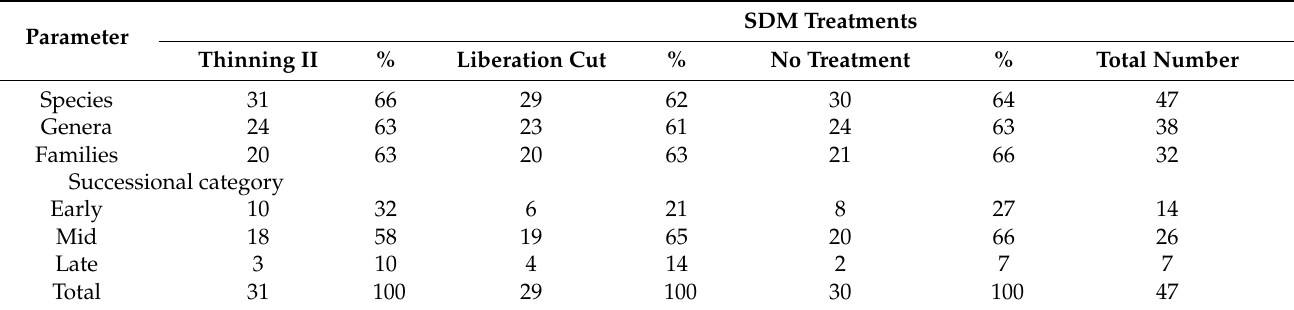
Table 1. Accumulated number and percentage of families, genera, and species recorded in different silvicultural treat- ments in the Ocotones forest, Chiapas, Mexico. Numbers of species are separated according to successional category. Parameter